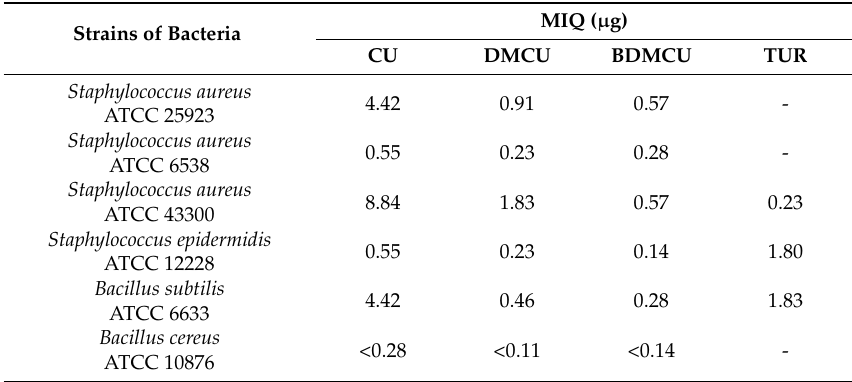
Table 2. Evaluation of the antimicrobial activity of four identified compounds against all tested Gram-positive bacteria strains, in relation to the isolated curcumin studied in a microdilution assay. The MIQ values are given in µ